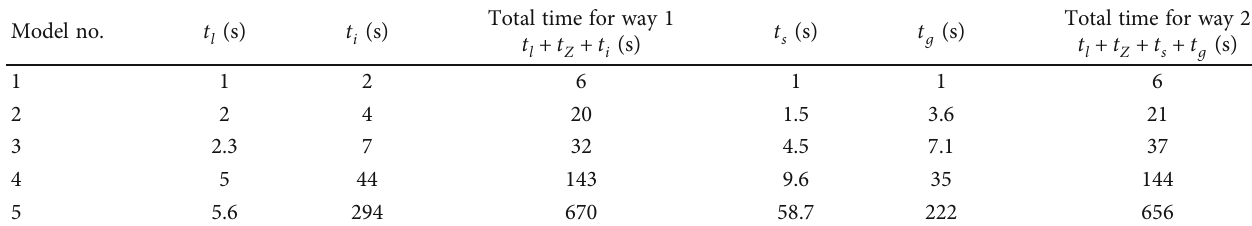
Table 2: Estimation of computation time for the whole problem solution. Model